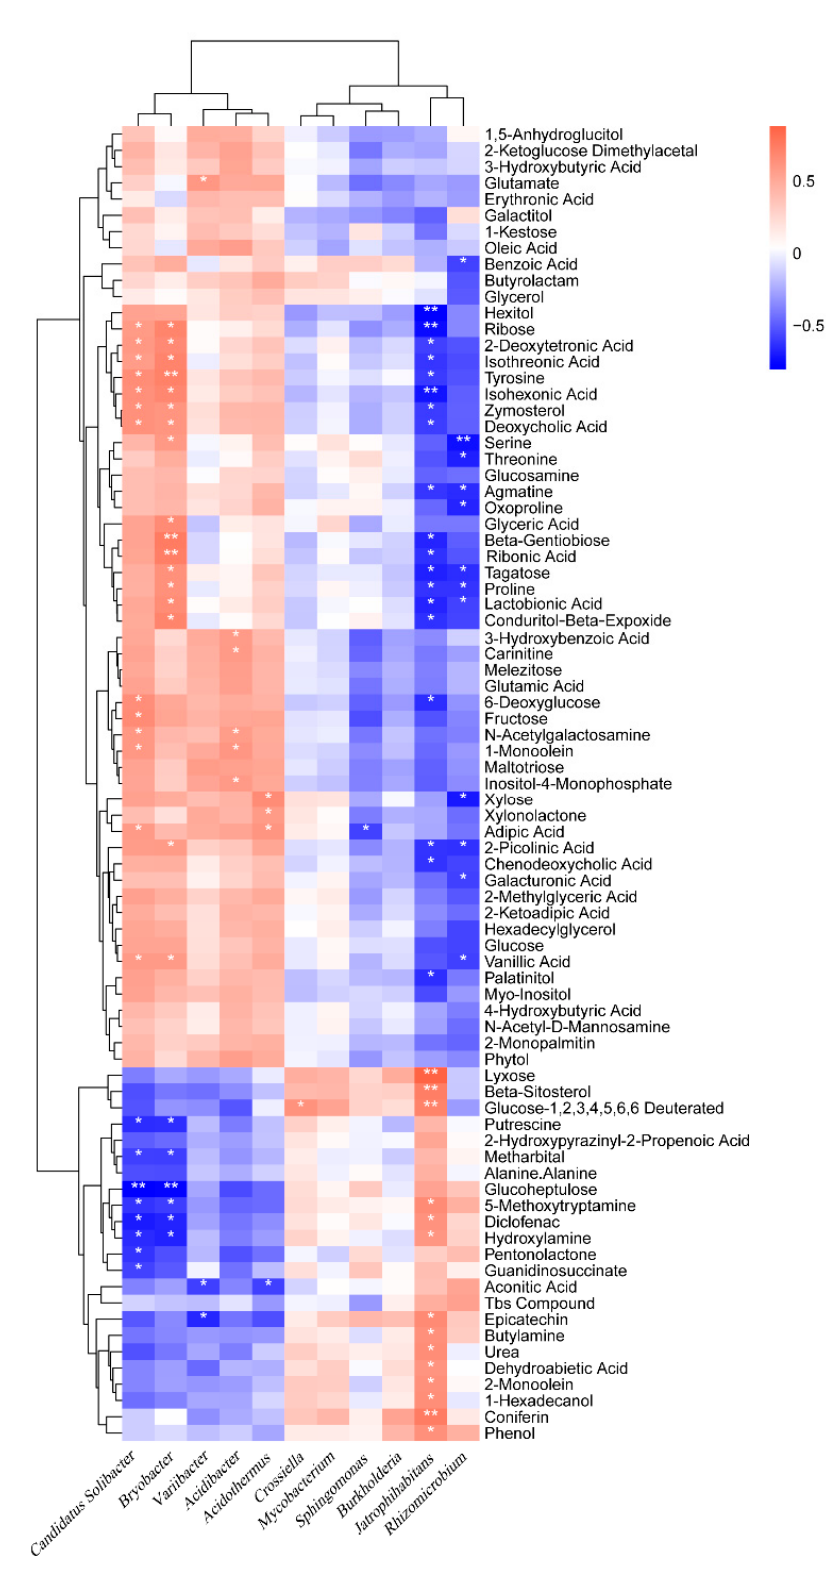
Figure 8. Correlation analysis between the microorganism relative abundances at the bacterial genus level and the relative metabolite contents of the humic acid treatment. “*” and “**” represents a significant correlation at p < 0.05 and p < 0.01, respectively. The magnitude of the correlation coefficient was indicated by the depth of the orange and blue scale, while the orange darker color is the greater positive correlation, and the blue darker color is the greater negative correlation. Furthermore, Bryobacter and Candidatus Soliactor were positively correlated with 17 and 13 metabolites, respectively, with reduced relative content and negatively correlated with 6 and 8 metabolites, respectively, with increased relative content. Crossella and My- cobacterium with significantly increased relative content were correlated with 1 and 0 of 58 metabolites, respectively. Acidibacter and Acidothiermus with significantly reduced relative content were significantly correlated with the contents of 5 and 4 secondary metabolites, respectively. This data shows that some functional bacteria play an important role in the change of the content of secondary metabolites. The relative content of fungi at the phylum (Figure S5), order (Figure S6), and genus (Figure 9) levels are correlated with the relative content of the main secondary metabolites